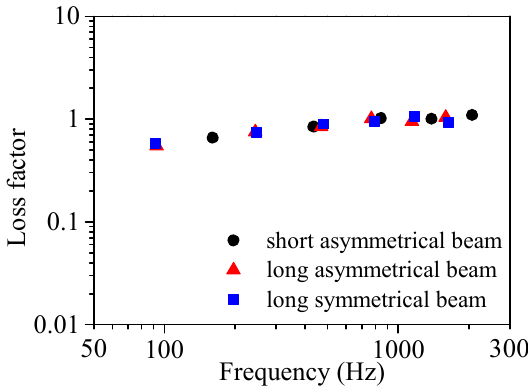
Figure 11. Test results of modal loss factors by three sandwich beam specimens. Appl. Sci. 2018 , 8 , x FOR PEER REVIEW